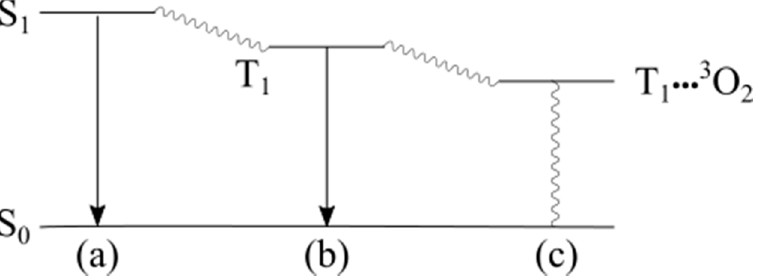
Figure 13. Electronic states and the Jablonski diagram: ( a ) fluorescence S 1 → S 0 ; ( b ) phosphores- cence T 1 → S 0 ; ( c ) phosphorescence quenching of T 1 by triplet oxygen T 1 … 3 O 2 where S 0 is the singlet T 1 → S 0 ; ( c ) phosphorescence quenching of T 1 by triplet oxygen T 1 ... 3 O 2 where S 0 is the ground state; S 1 is the lowest energy singlet excited state; and T 1 is the lowest energy excited tri- plet state.